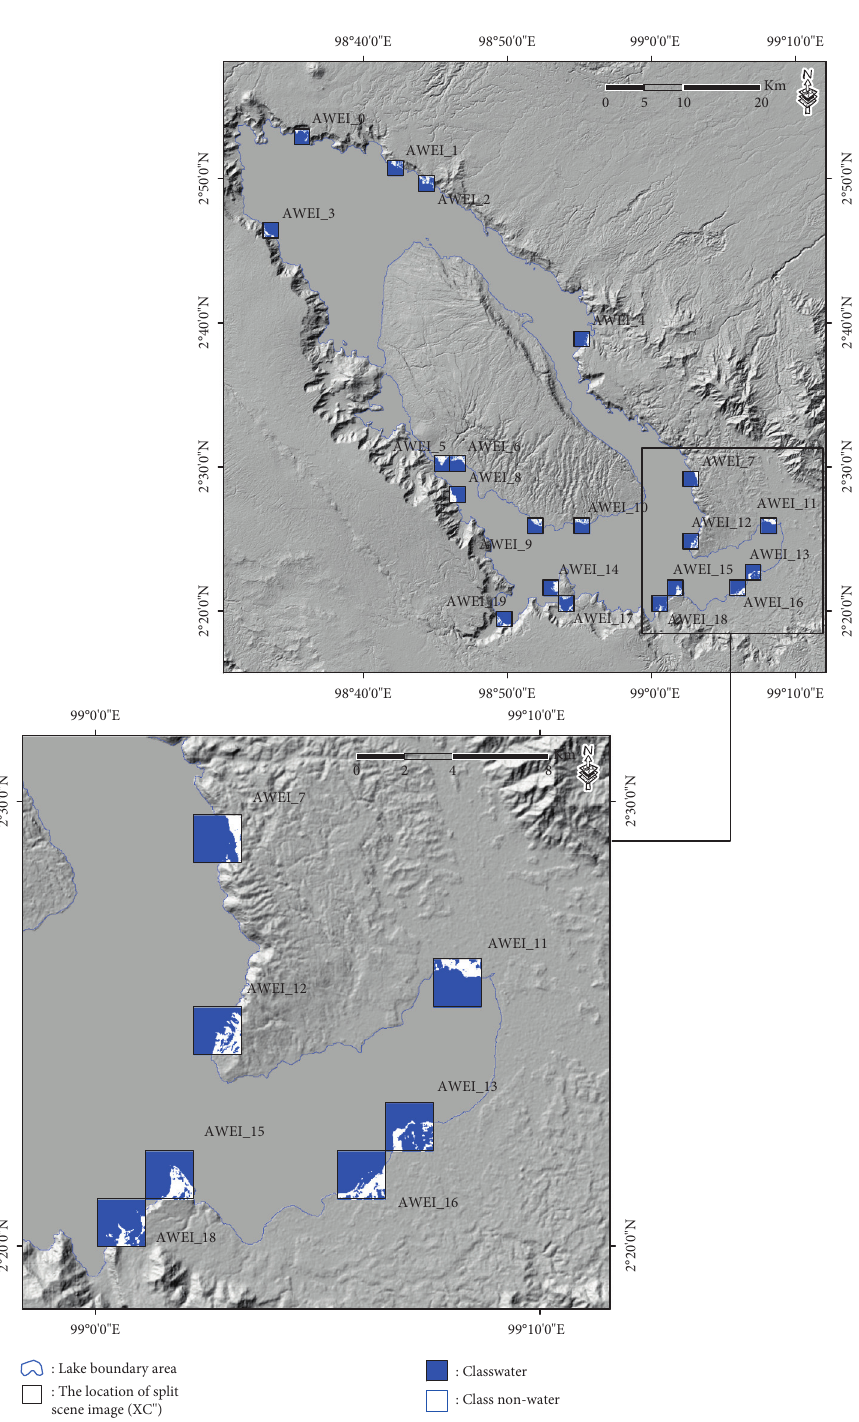
Figure 6: Location of split scene image selection in the scene data ( XC ″ ) of the subscene images ( XCi ″ ) with a size of 2km × 2 km based on the equal interval threshold